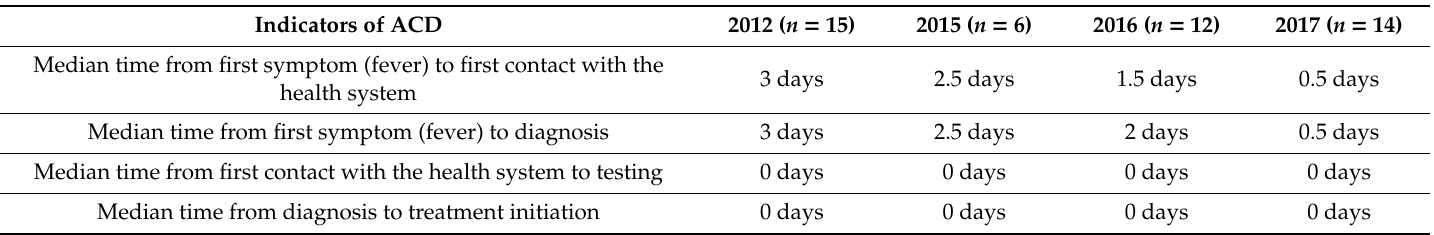
Table 6. Indicators of malaria Pro-Active Case Detection program for malaria cases actively detected (n), Municipality of Evrotas,